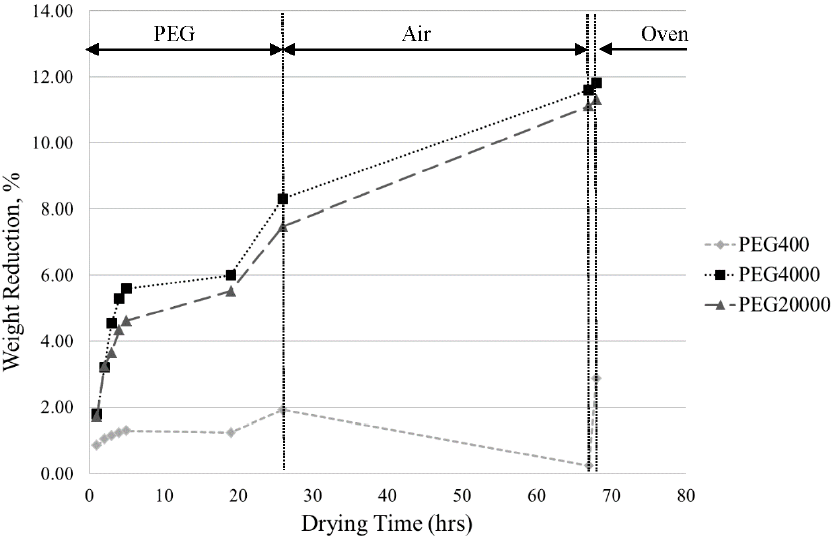
Figure 2. Sample weight reduction by PEG 400, 4000 and 20,000 at a 30% concentrated aqueous solution followed by air drying and oven drying.